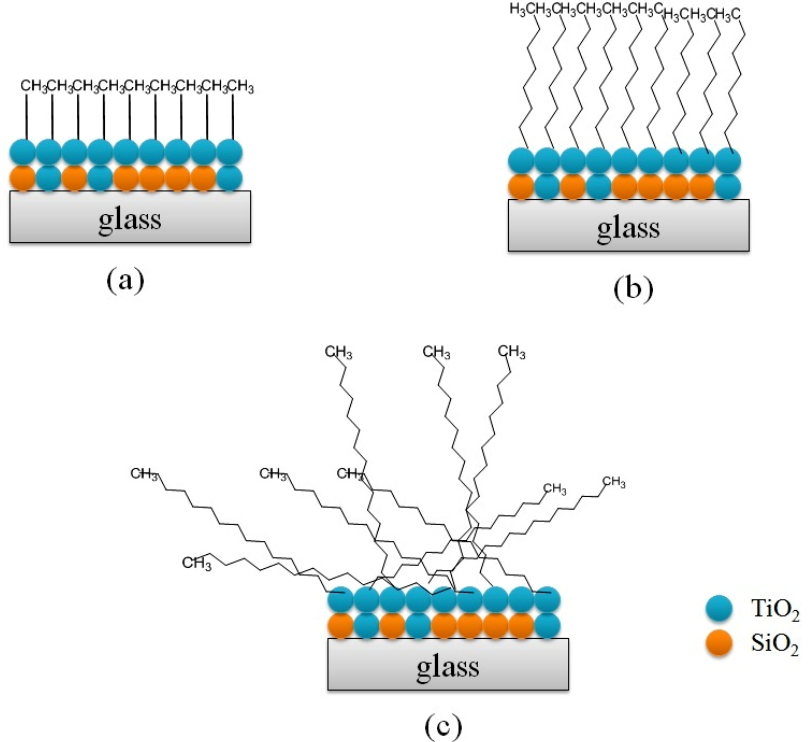
Figure 13. The prediction of molecule conformation of ( a ) SiO 2 -TiO 2 -MTMS, ( b ) SiO 2 -TiO 2 -OTMS, and ( c ) SiO 2 -TiO 2 -HDTMS-coated glass.